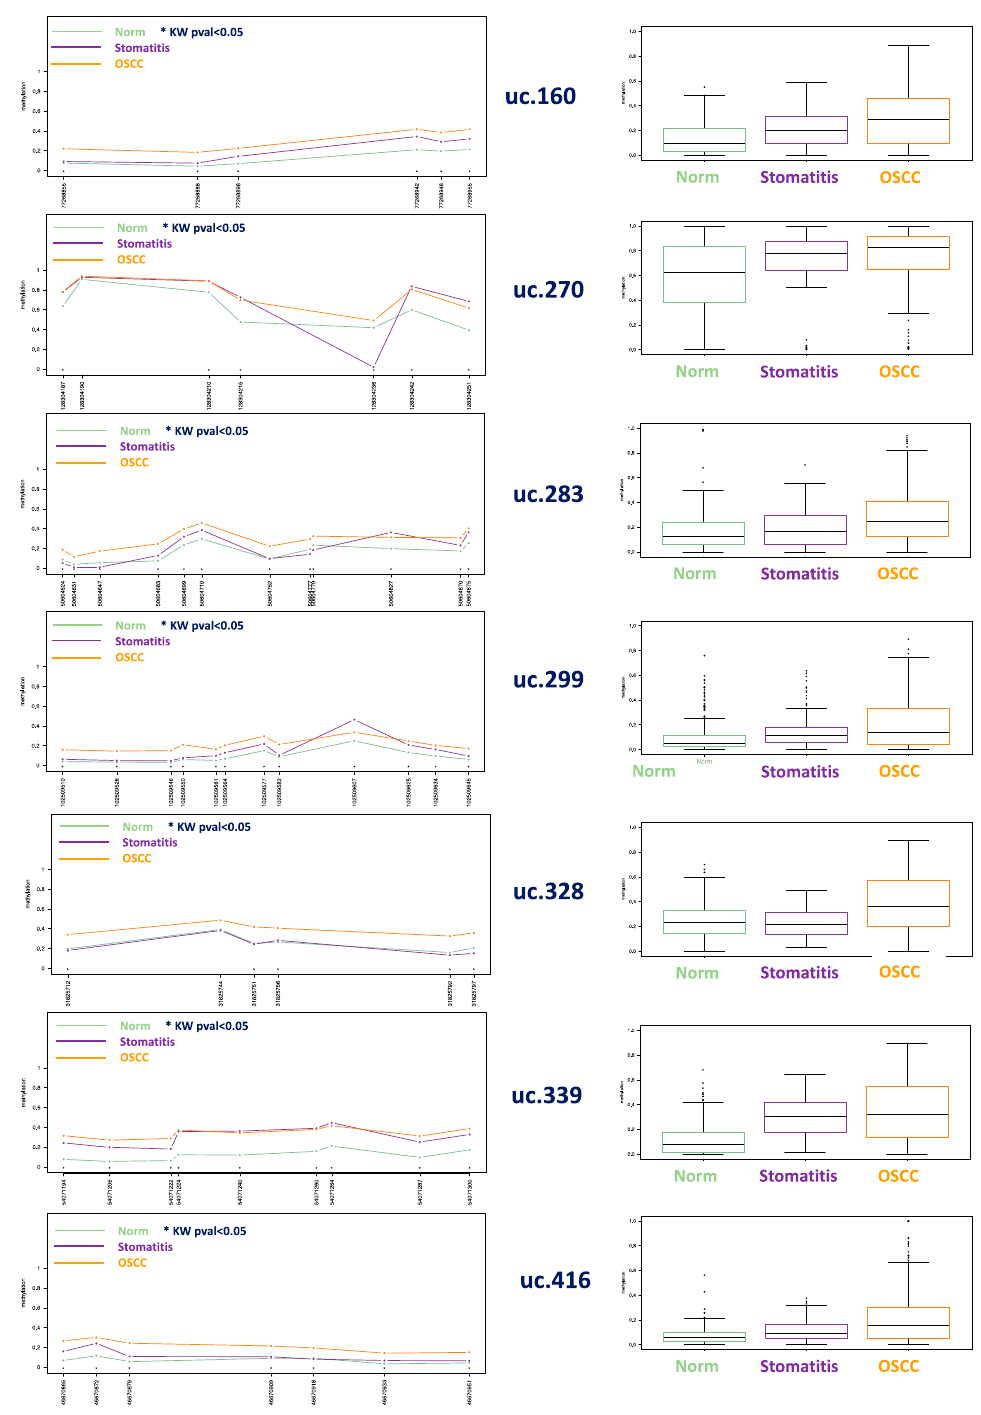
Figure 1. (Left column ): methylation plots for each of the seven UCNEs comparing all CpG positions (59 in total) in 50 SCCs with 14 feline stomatitis and 62 normal cases from all mammalian species evaluated in this study; the profile plot summarizes the methylation panorama in percentage (values ranging from 0 to 1) comparing the three sample groups, labelling with an asterisk( * ) those CpGs that show statistical differences according to the nonparametric Kruskal–Wallis test; uc.160, uc.270, uc.283, uc.299, uc.339, and uc.416 displayed p -values < 0.01 in all positions marked with *; uc.328 showed p = 0.014 for CpG 31825712, p = 0.019 for CpG 31825756, p < 0.01 for CpG 31825792, CpG 31825751, and CpG 31825797 (see Supplementary Table S1 for details). ( Right column ): boxplot for each group of samples considering all the CpGs evaluated.